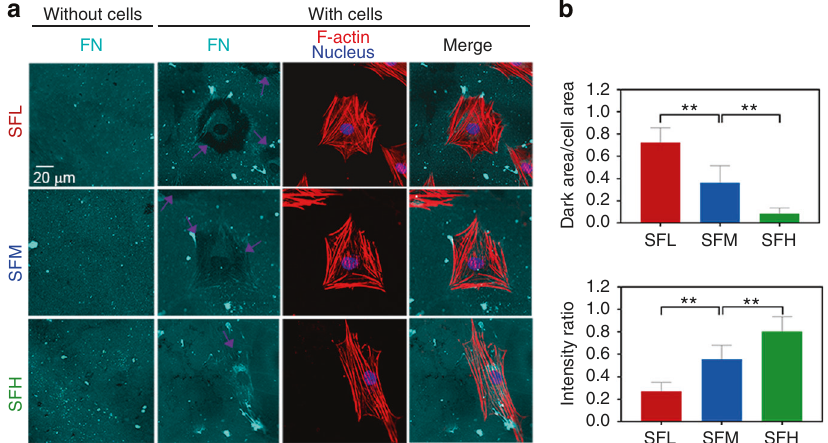
Fig. 3 Interfacial stability of adsorbed FN on different substrates in a cell culture environment. a Immuno fl uorescence staining of adsorbed FN (cyan) on different SF substrates with and without BMSCs cultured for 24 h, together with F-actin (red) and nuclei (blue). The purple arrows indicate the detached FN underlying the cells. b Ratio of the FN dark area underlying the cell outline to the cell area. c Ratio of FN intensity underlying the cell outline to that of the background. Error bars represent one standard deviation. (* P < 0.05 and ** P < analysis (Fig. 5b) revealed that the nuclear-cytoplasmic ratio of Intracellular mechanotransduction of YAP/TAZ and RUNX2 on YAP/TAZ in BMSCs was lower on the SFL surfaces than on the different SF substrates SFH surfaces at day 1 and on the SFM ( P < 0.05) and SFH The immunostaining of YAP/TAZ in Fig. 5a shows that YAP/TAZ ( P < 0.01) surfaces at day 3. was translocated to the nucleus for all three groups, and YAP/ Similarly, immunostaining of RUNX2 in BMSCs (Fig. 5a) TAZ was more abundant in the nuclei of BMSCs on the SFH indicated that RUNX2 nuclear translocation was not evident at surfaces than on the SFL surfaces at days 1 and 3. Quantitative